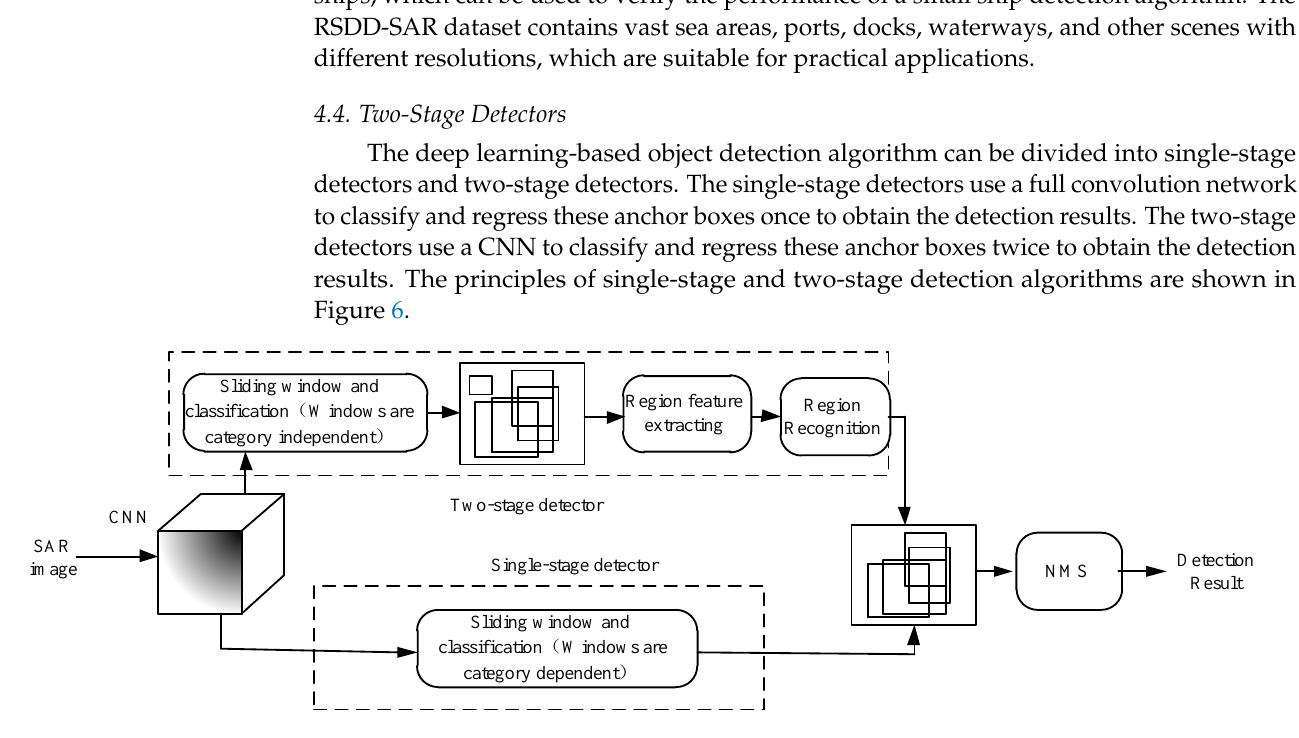
Figure 6. The principle of single-stage and two-stage detectors. Classical two-stage detectors are Faster R-CNN, R-FCN (fully convolutional net- work) [193], feature pyramid networks (FPN) [194], Cascade R-CNN [195], Mask R-